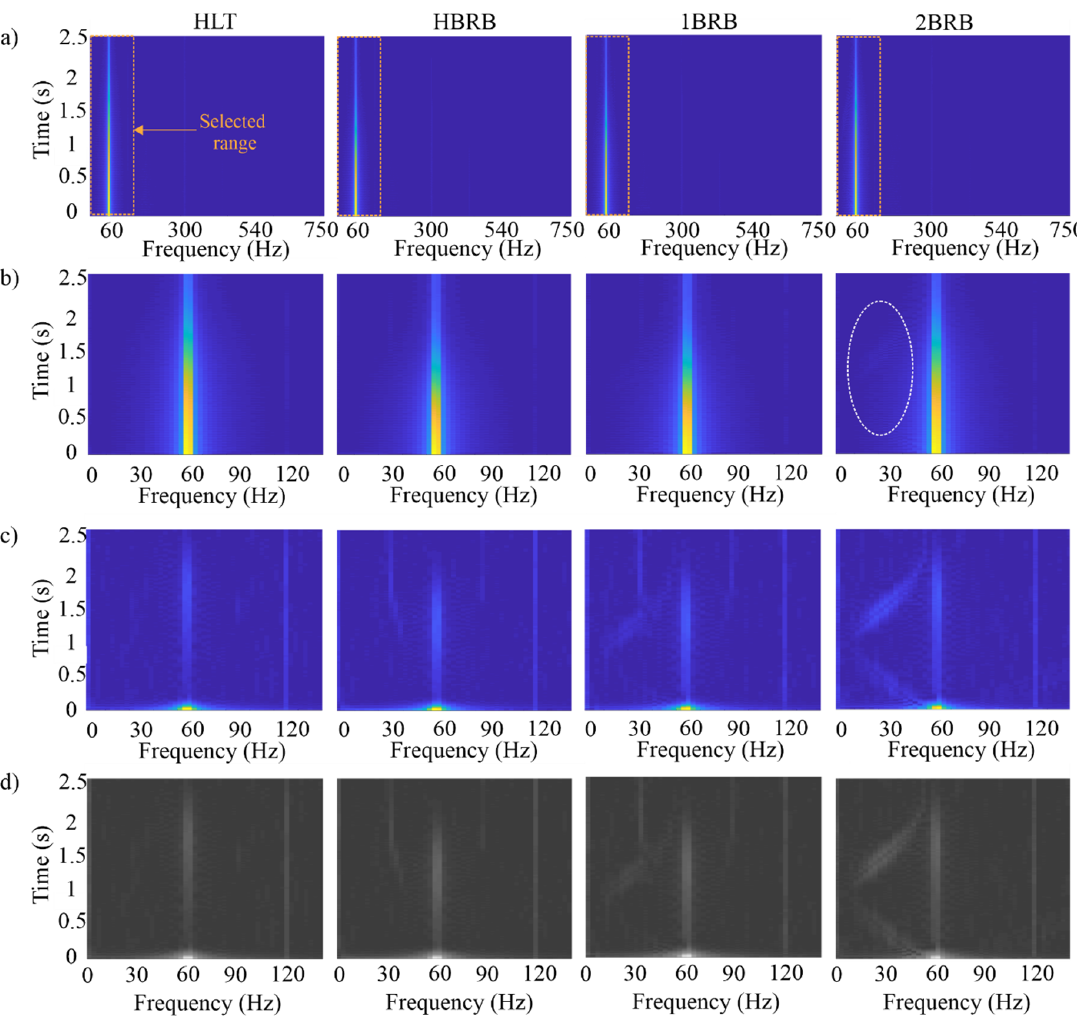
Figure 10. Time–frequency plane for: ( a ) the STFT of the current signals shown in Figure 9; ( b ) the STFT in the selected range; ( c ) the STFT after the Notch filter application in the time domain; and ( d ) the STFT in the selected range in grayscale.